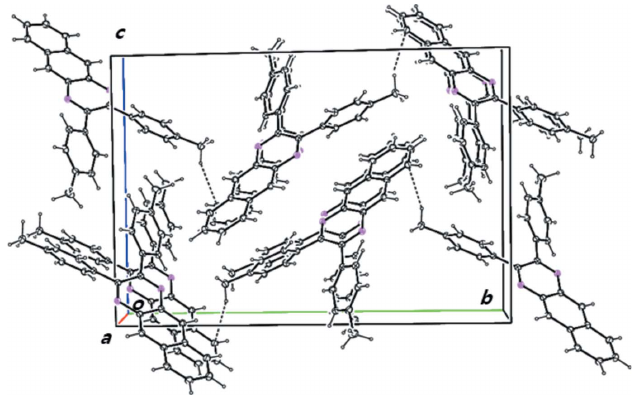
Fig. 1. The benzoquinoxaline ring system (atoms N1/C2/C3/